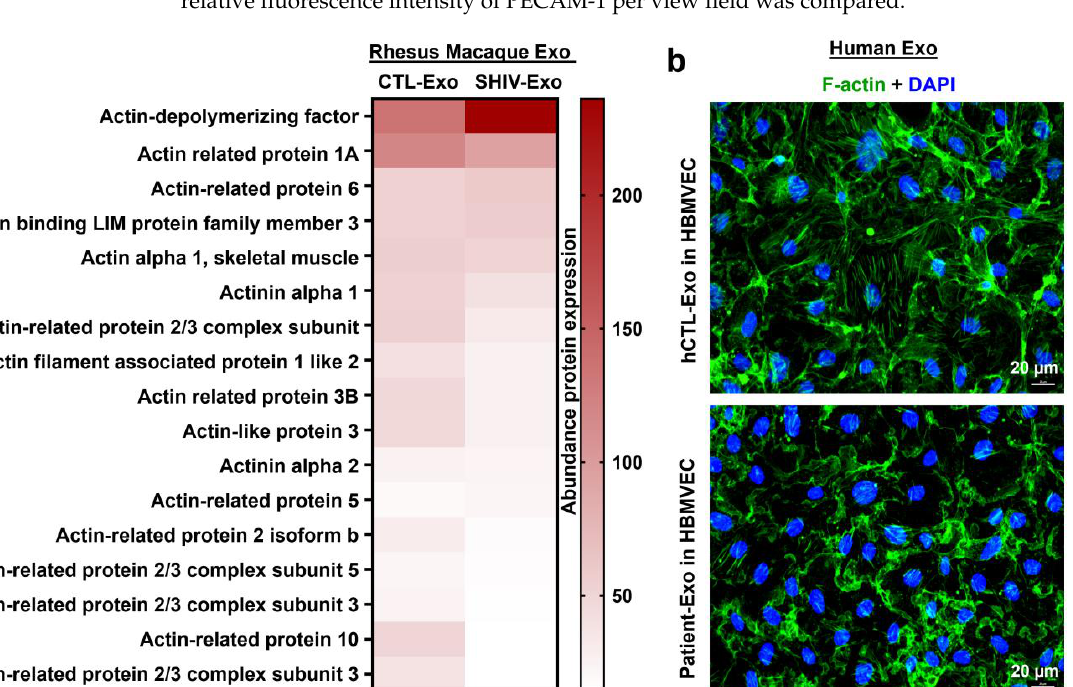
expressing PECAM-1 after 24 h treatment (10 µ g/mL) with either hCTL-Exo or Patient-Exo. ( d ) The